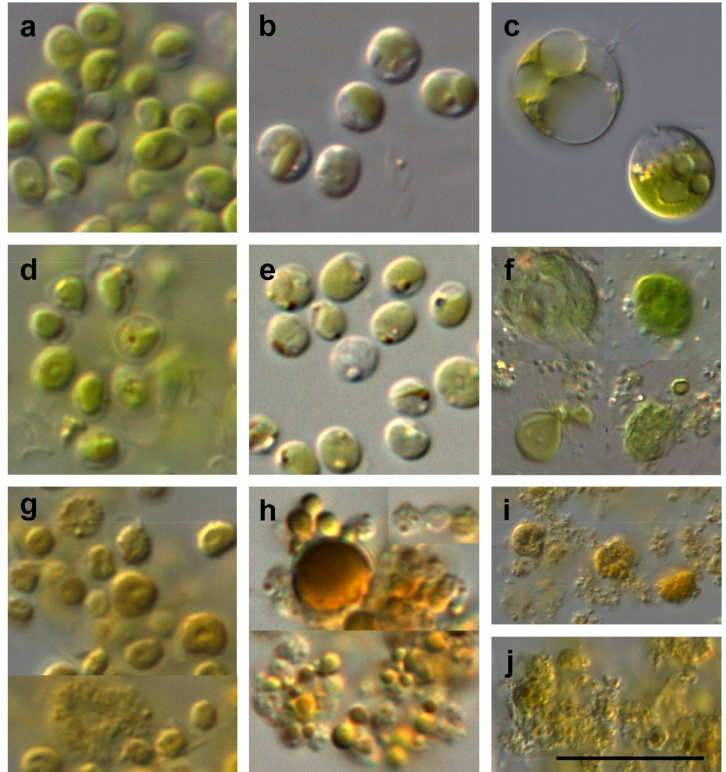
Figure 1. Light micrographs of Chlorella sorokiniana ( a , d , g ), Nannochloropsis gaditana ( b , e , h ), and Dunaliella tertiolecta ( c , f , i , j ) before and after steam explosion. ( a , b , c ) Live cells; ( d , e ) Thawed material; ( f ) D. tertiolecta after centrifugation; ( g , h , i ) Algal material after steam explosion with acid; ( j ) D. tertiolecta after steam explosion without acid. Scale bar corresponds to 10 µ m in ( a – f ) and to 20 µ m in ( g – j